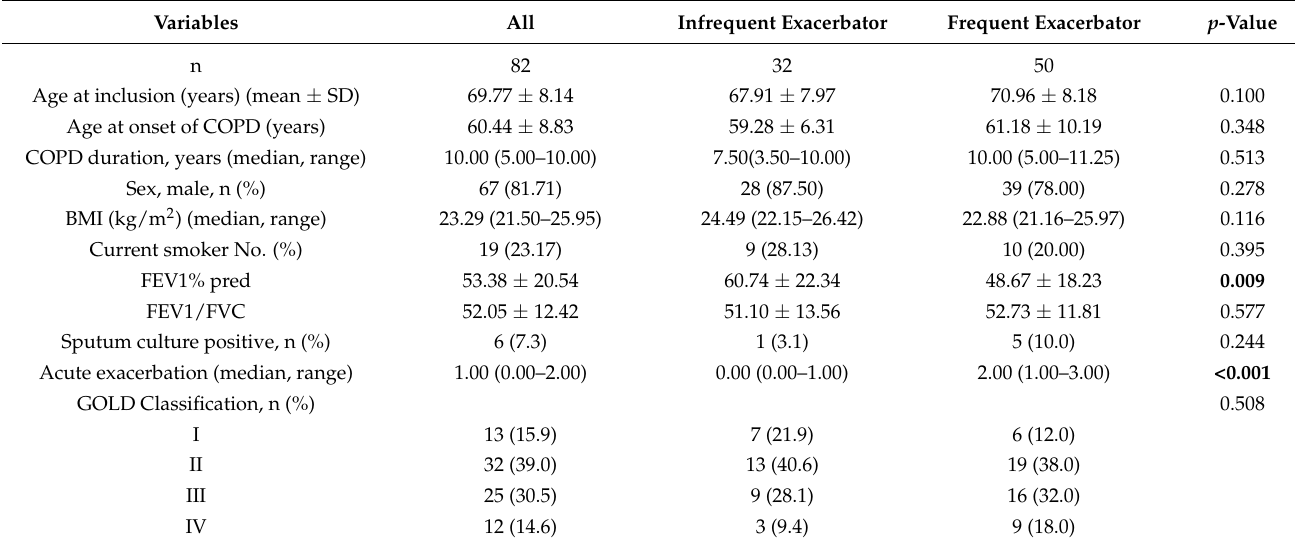
Table 1. Demographic characteristics of the COPD